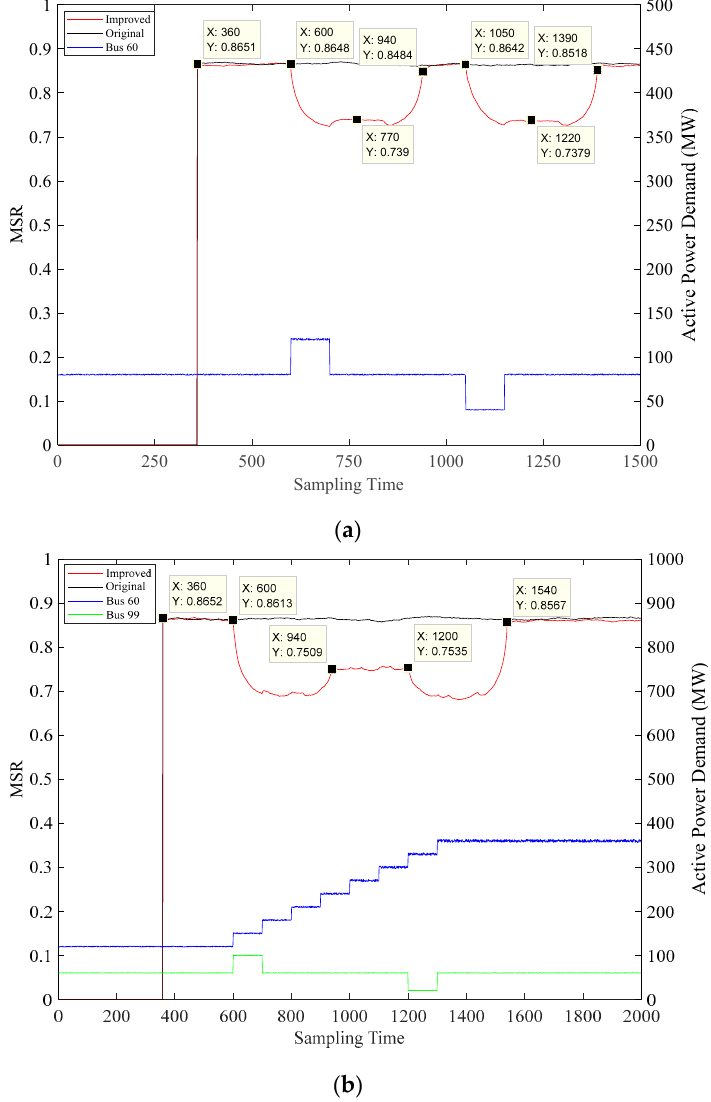
Figure 2. ( a ) Swell and sag signals (SNR = 95), ( b ) multiple signals (SNR = 90), MSR- t curves of the improved and original event detectors in the situation with missing data.